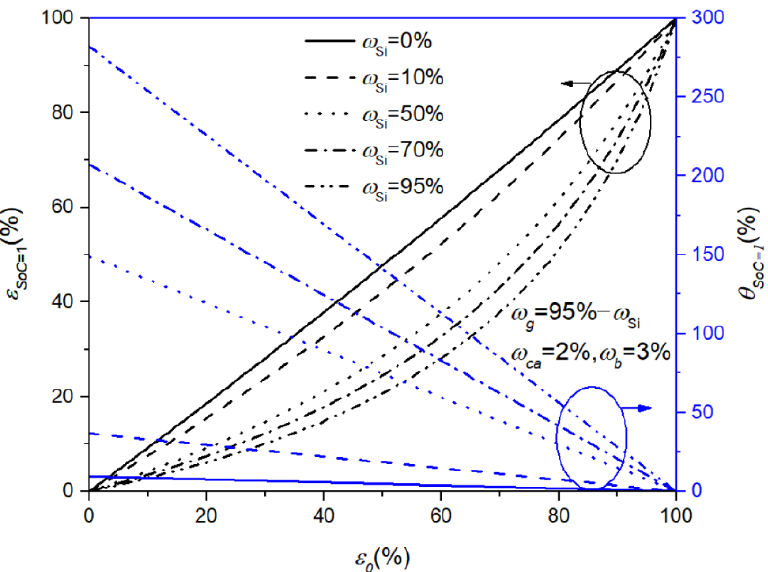
Figure 4. The porosity and volume change of the electrode at SoC = 1 as a function of the initial porosity ( SoC = 0) for different mass fractions of Si.